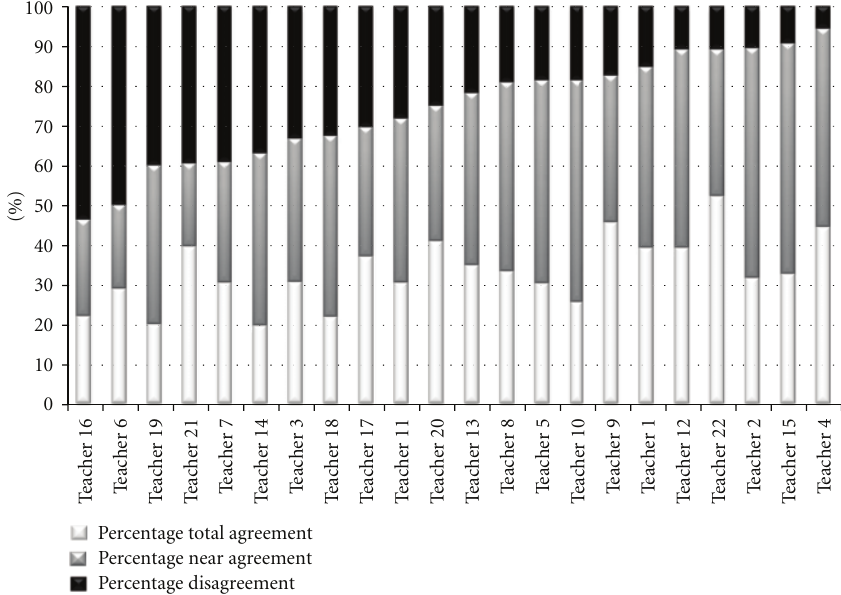
Figure 1: The distributions of total agreement, near agreement, and disagreement for each teacher. Teachers labelled 14 and 15 are the same teacher making two ratings in relation to the two di ff erent students with ASC in the same